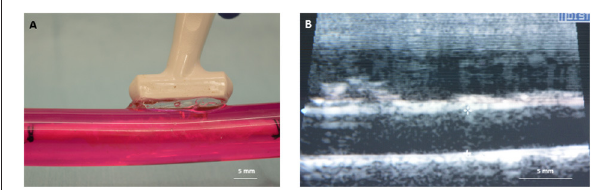
FIGURE 5 | Diameter measurement of explanted arteries. (A) An ultrasound probe can be directly placed on the outer sleeve of the bioreactor housing to measure the diameter. (B) Ultrasound image showing the inner diameter of the explanted